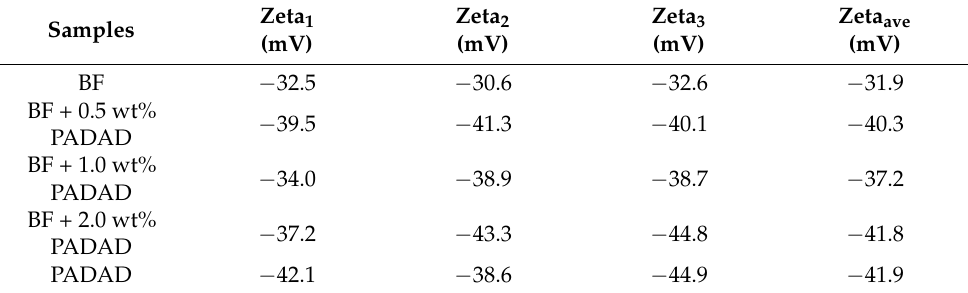
Table 4. Zeta potential of BF or BF/copolymer suspension.